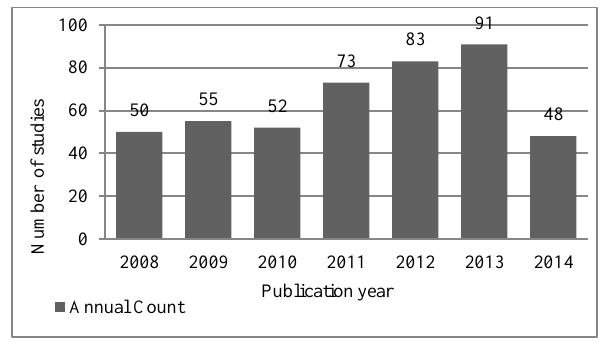
Fig. 1. Papers using CIS data (2008–2014) (the author’s chart based on Es- Sadki,